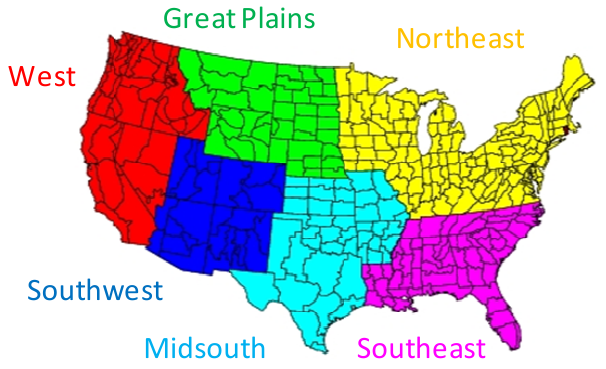
Fig. 11. Definition of sub-regions used in analysis.